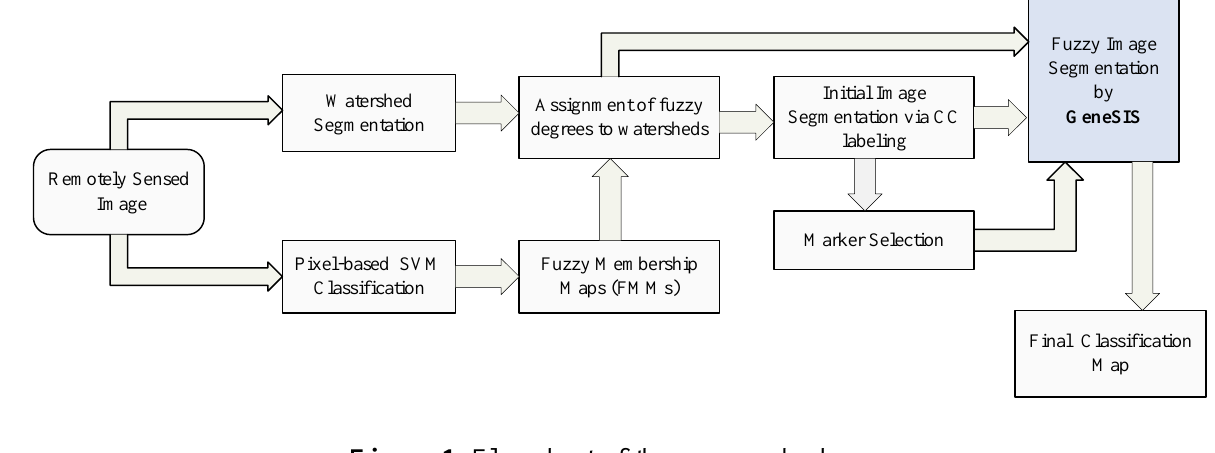
Figure 1. Flowchart of the proposed